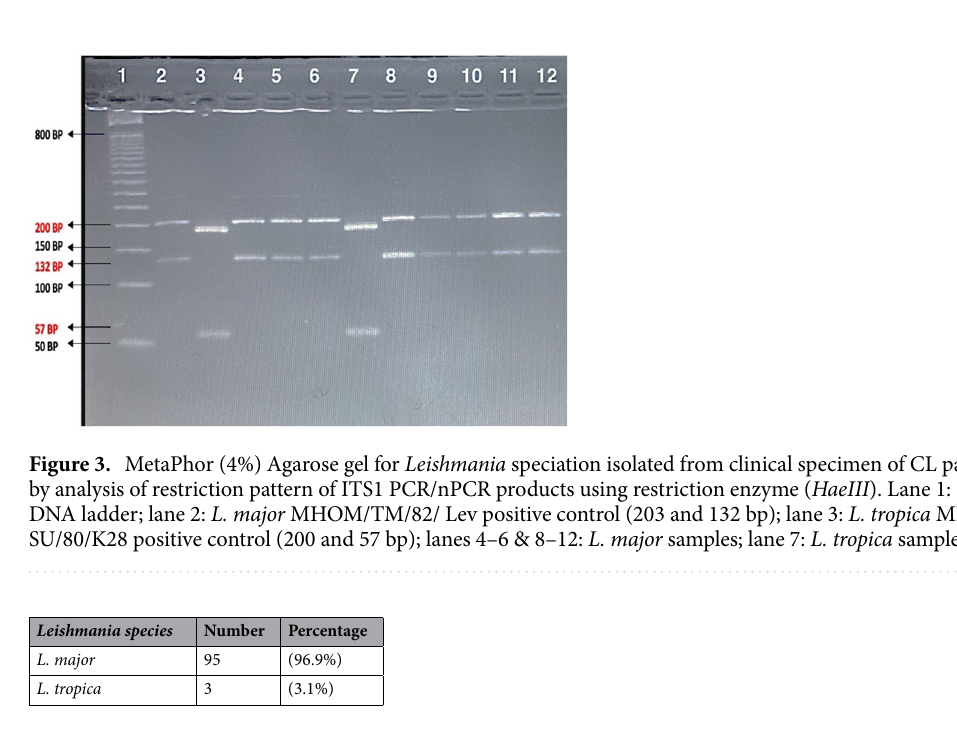
Table 4. Results of genotyping using RFLP